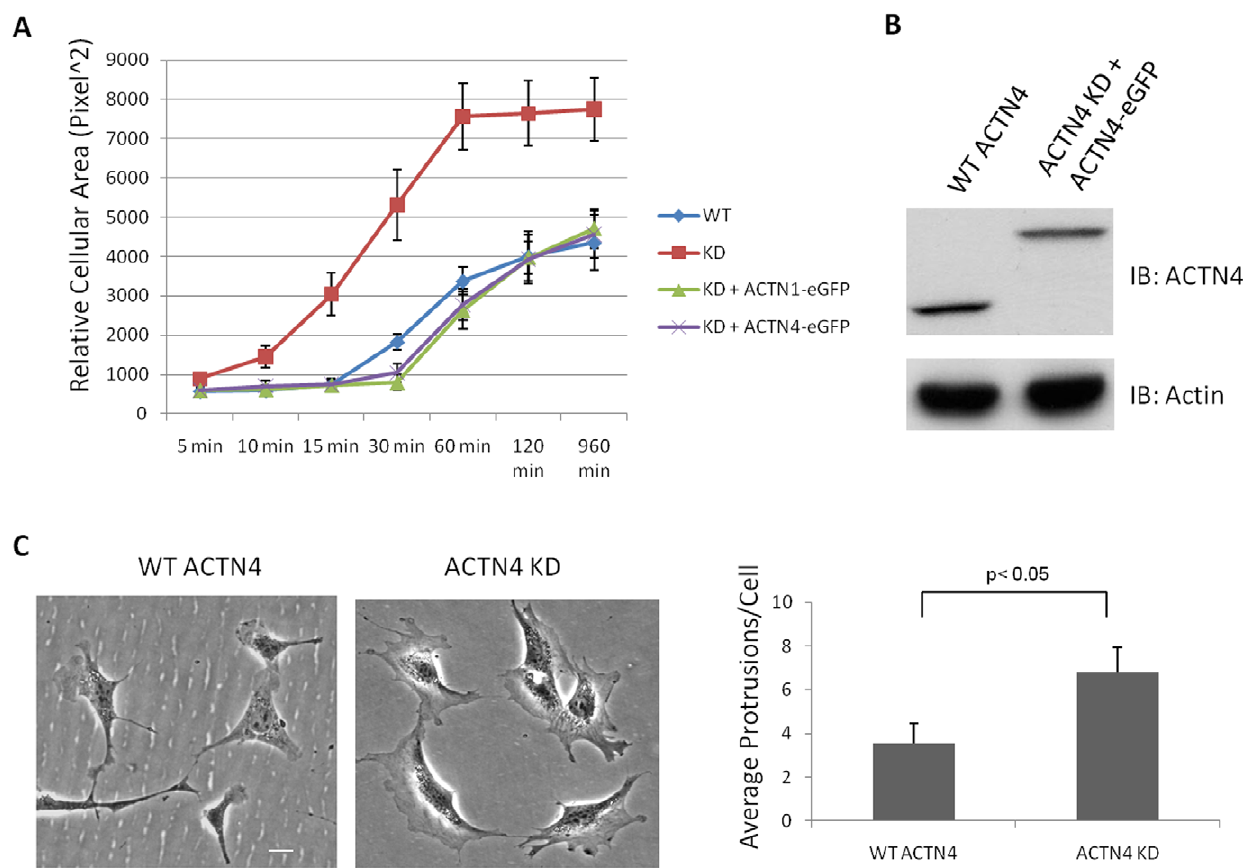
Figure 2. Knockdown of ACTN4 hastens cell spreading of murine lung fibroblasts. (A) Murine lung fibroblasts (WT ACTN4 and ACTN4 KD) were transiently transfected to express the designated constructs. These cells were trypsined and then plated in 6-well plates coated with 1 m g/ml fibronectin. After culturing for 5 min, 10 min, 15 min, 30 min, 1 hr, 2 hr and 16 hr, respectively, unattached cells were washed away with PBS. Adhesive cells were fixed with 2% formaldehyde for 30 min at room temperature followed by imaging under fluorescent microscope. The cellular cross-sectional area of attached cells with GFP fluorescence was measured by using ImageJ software. Quantification represents the average cellular cross-sectional area ( 6 the standard deviation) of at least 50 individual fluorescent cells chosen randomly. (B) Immunoblotting of endogenous ACTN4 and exogenous human wild type ACTN4-eGFP. The immunoblotting results were the representative of three independent experiments. (C) Morphology of both WT ACTN4 and ACTN4 KD fibroblasts grown in Petri dishes and the quantification of protrusions per cell. Images present both WT and KD fibroblasts chosen randomly. Quantification represents the average protrusions per cell ( 6 the standard deviation) of at least 50 individual cells chosen randomly. Bar =5 m